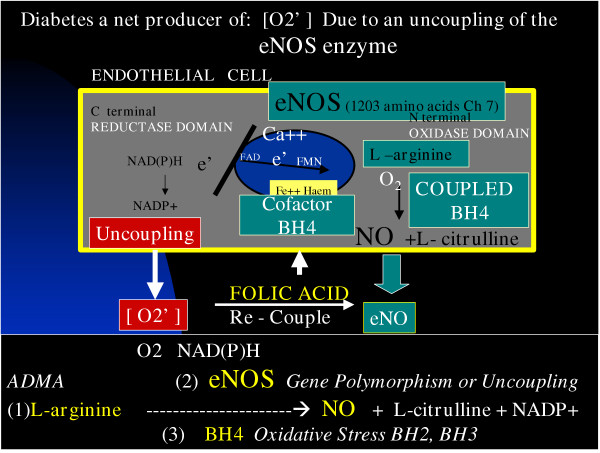
Uncoupling of the eNOS enzyme resulting in the net production of superoxide instead of the protective endothelial nitric oxide (eNO). This image depicts the eNOS enzyme reaction and resultant production of the protective antioxidant, anti-inflammatory gas product eNO. Oxygen reacts with the eNOS enzyme in which the tetrahydrobiopertin (BH4) cofactor has coupled nicotinamide dinucleotide phosphate reduced (NAD(P)H) enzyme with L-arginine to be converted to nitric oxide (NO) and L-citrulline. When eNOS uncoupling occurs the NAD(P)H enzyme reacts with O2 and the endothelial cell becomes a net producer of superoxide (O2•) instead of the protective endothelial NO. This figure demonstrates the additional redox stress placed upon the arterial vessel wall and capillaries in patients with MS, PD, and overt T2DM.